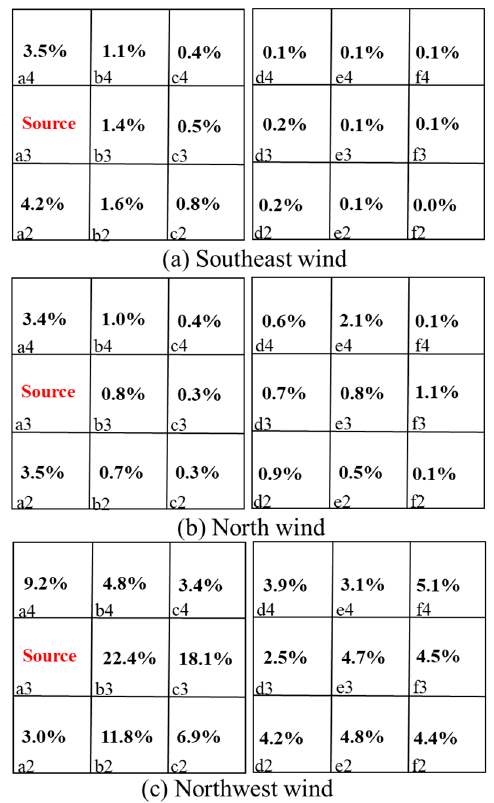
Figure 14. Re-entry ratio ( R K ) of each room under three wind directions with the pollutant source located in room a3 in D3. a1,2,3,4-e1,2,3,4 represent the number of dormitory room.